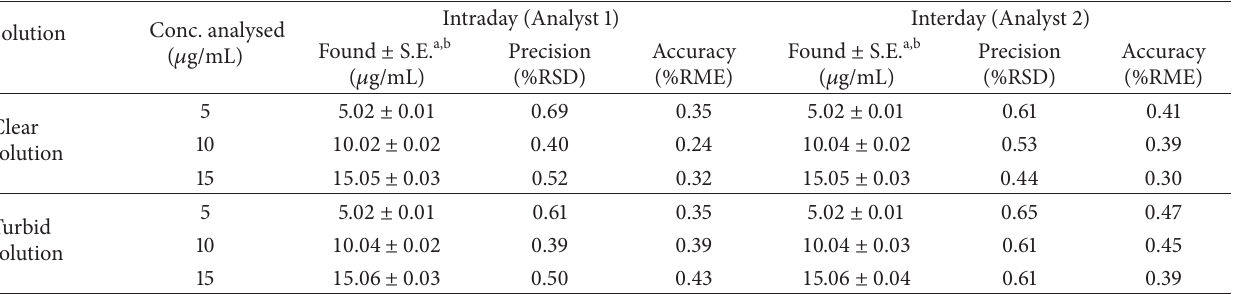
Table 3: Precision and accuracy of proposed method ( 𝑛 = 6 ).